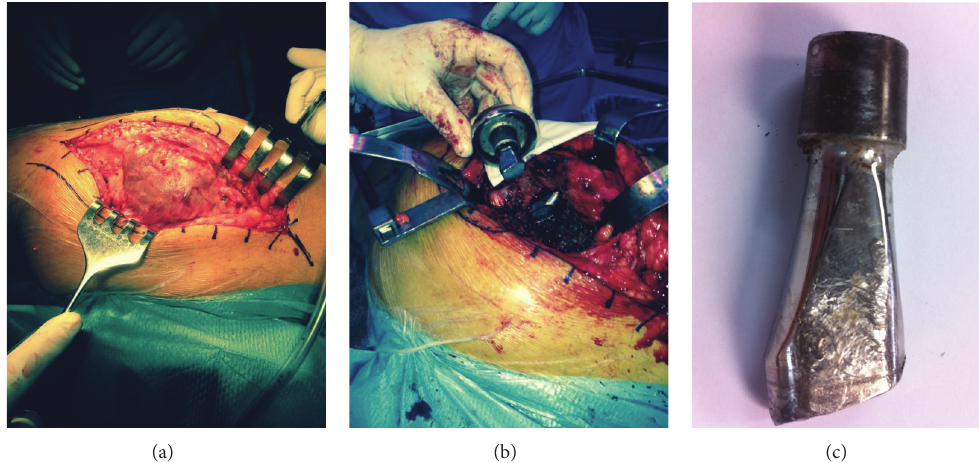
Figure 2: (a) An important pseudotumoral well-organized periprosthetic tissue reaction was found surrounding the joint. (b, c) The rupture of the modular neck was confirmed; failure of the implant seemed to have originated on the anterior aspect of the tapper